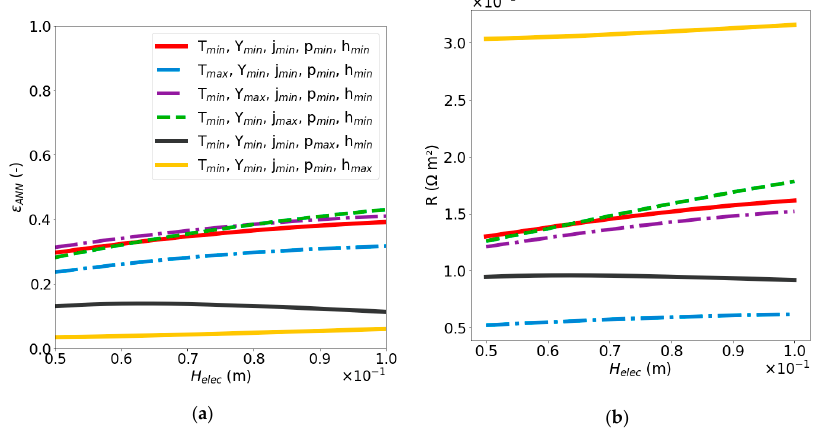
Figure 6. Void fraction ε ANN ( a ) and ohmic resistance R ( b ) depending current density in [1;10] kA m − 2 .